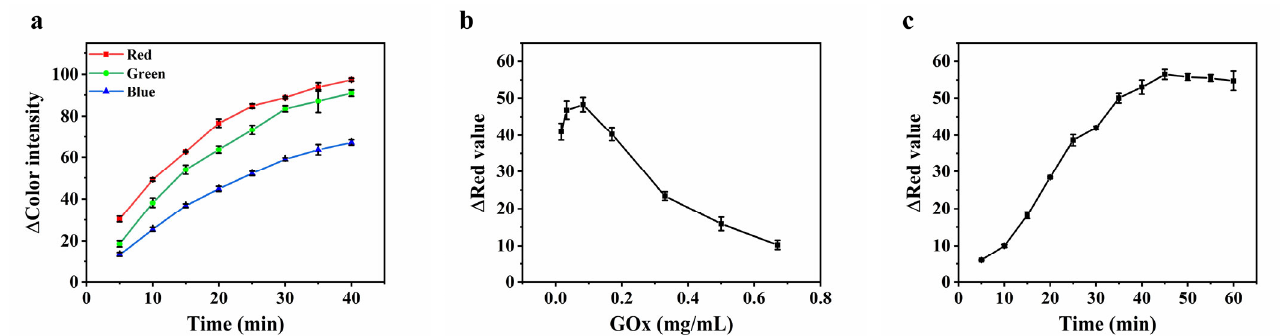
Figure 4. Effect of reaction time on the determination of H 2 O 2 by the paper device with KI ‐ TMB system ( a ). Effects of GOx concentration ( b ) and reaction time ( c ) on the determination of glucose by the paper device with KI ‐ TMB ‐ GOx system.